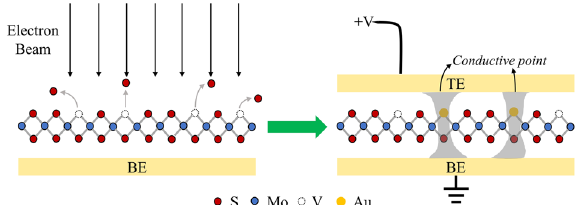
Fig. 5 Illustration of irradiation effect on MoS 2 fi lm. High-energy electron beam breaks Mo-S bonds, leading to the creation of sulfur vacancies during the irradiation process. In the fabricated 2D memristors, these sulfur vacancies, with the metal atoms/ions from electrodes migrating into them, promote the formation of one or more virtual conductive point(s), which is responsible for the resistive switching